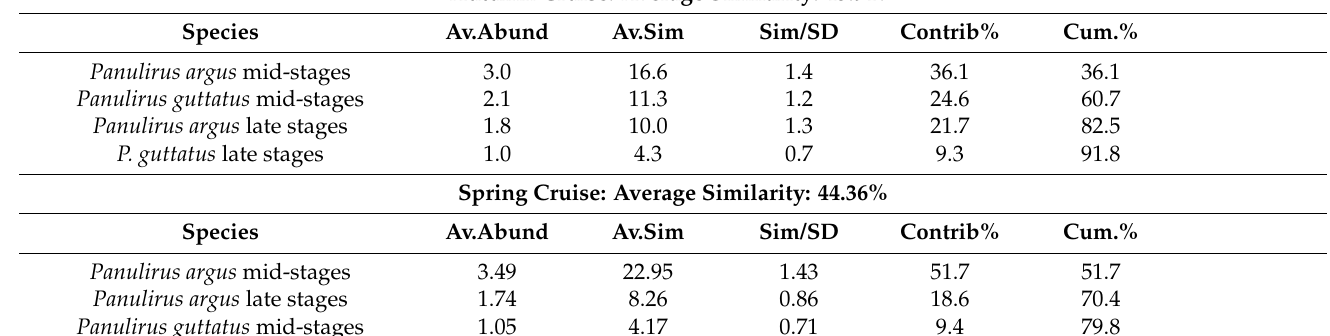
Table A1. Similarity measures within and between seasons (cruises). Analysis of similarity percentage (SIMPER) for phyllosomata assemblages within the autumn cruise and the spring cruise, and of dissimilarity percentage between cruises. Av.Abund: average abundance; Av.Sim: average similarity; Sim/SD: similarity/standard deviation; Contrib%: contribution in %; Cum%: cumulative contribution in %; Av.Diss: average dissimilarity; Diss/SD, dissimilarity/standard deviation. Autumn Cruise: Average Similarity: